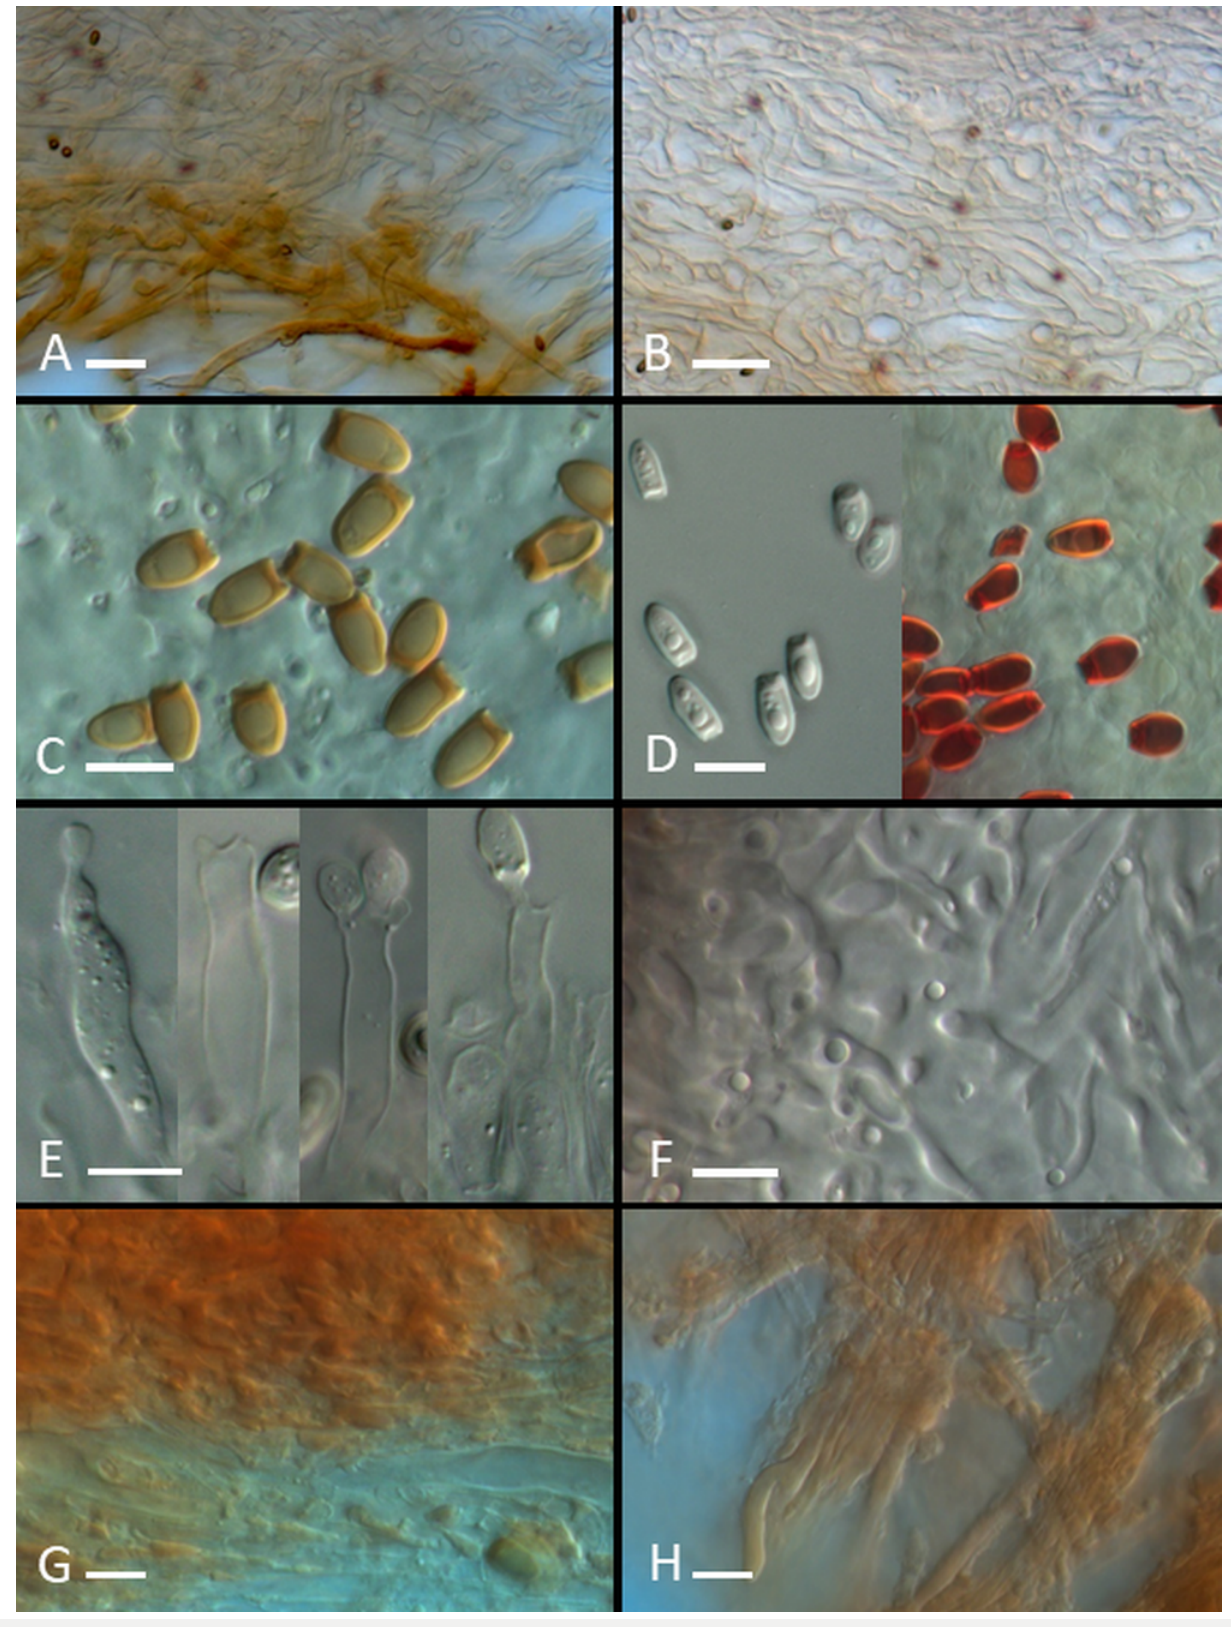
F igure 3 Micromorphological structures of hypogeous fungi: ( A,B ) Cross section of outer ( A ) and middle ( B ) peridium layers of Melanogaster luteus ; ( C,D ) mature ( C ) and immature ( D ) spores of Rhizopogon melanogastroides (left – in water, right – in Melzer’s reagent); ( E ) basidia of R. melanogastroides (first from the left – immature basidium); ( F ) section of dissepiment of R. melanogastroides ; ( G,H ) section ofthe inner ( G ) and outer ( H ) peridium layers of R. melanogastroides . Scale: 10 µ m. Photo: P. M. ( A,B ) KRA F-TPN/19- 0006; ( C–H ) KRA